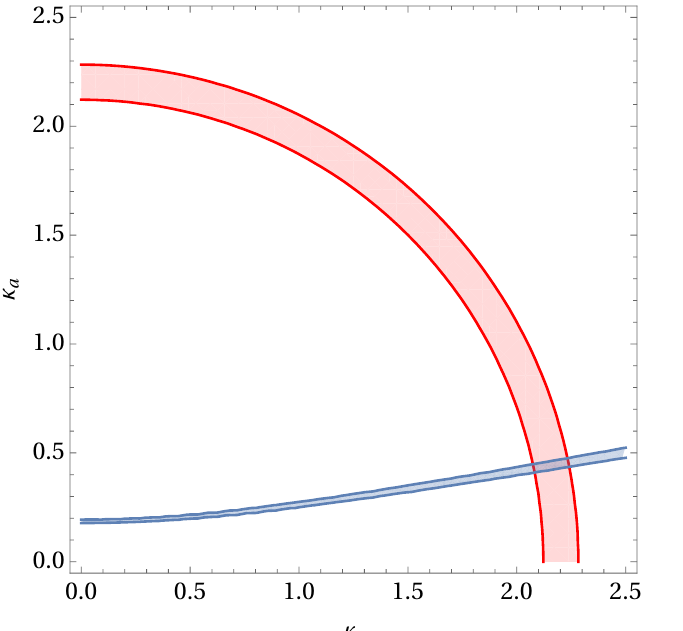
and (cid:1) m 2 are taken from ref. [73] and that of (cid:1) m 2 21 31